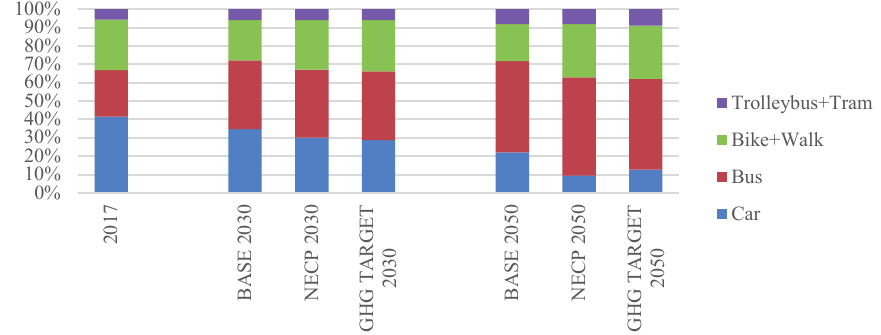
Fig. 15. Structure of modes of passenger transport for short distances.